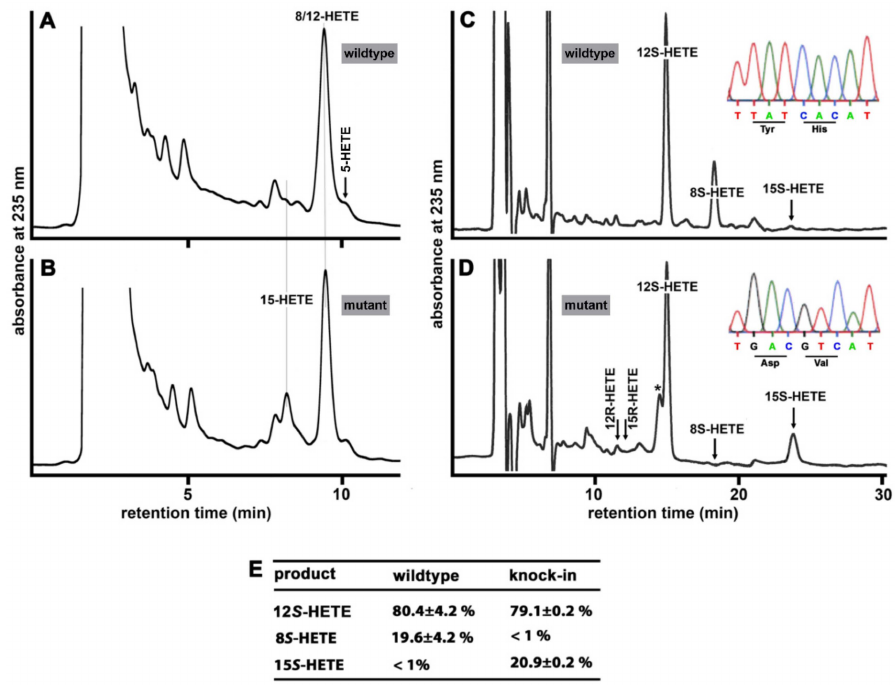
Figure 4. Ex vivo Alox activity assays using PMA-treated tail epidermis as source of mouse Alox15b. Expression of Alox15b was induced in mouse tail epidermis by treatment with PMA and ex vivo activity assays were carried out using aliquots of a homogenate supernatant of mouse tail epidermis (see Section 2). ( A ) RP-HPLC analysis of the product pattern formed from AA when PMA-treated tail epidermis of wildtype mice was used as enzyme source. ( B ) RP-HPLC analysis of the product pattern formed from AA when PMA-treated tail epidermis of Alox15b -KI mice was used as enzyme source. ( C ) The conjugated dienes formed by PMA-treated wildtype epidermis were prepared with RP-HPLC (panel A) and further analyzed by combined normal phase/chiral phase HPLC (see Section 2). Inset: Representative genotyping chromatogram. ( D ) The conjugated dienes formed by PMA-treated Alox15b KI epidermis were prepared with RP-HPLC (panel B) and further analyzed by combined normal phase/chiral phase HPLC (see Section 2). * This front shoulder peak did not show a conjugated diene chromophore. Inset: representative genotyping chromatograms. ( E ) Statistical evaluation of the major AA oxygenation products. For this evaluation, the experimental raw data of NP/CP-HPLC were